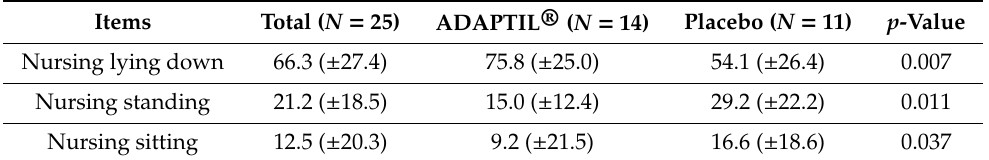
Table 5. Nursing position of the bitches during the full weaning period (percentage of total time spent to nurse +